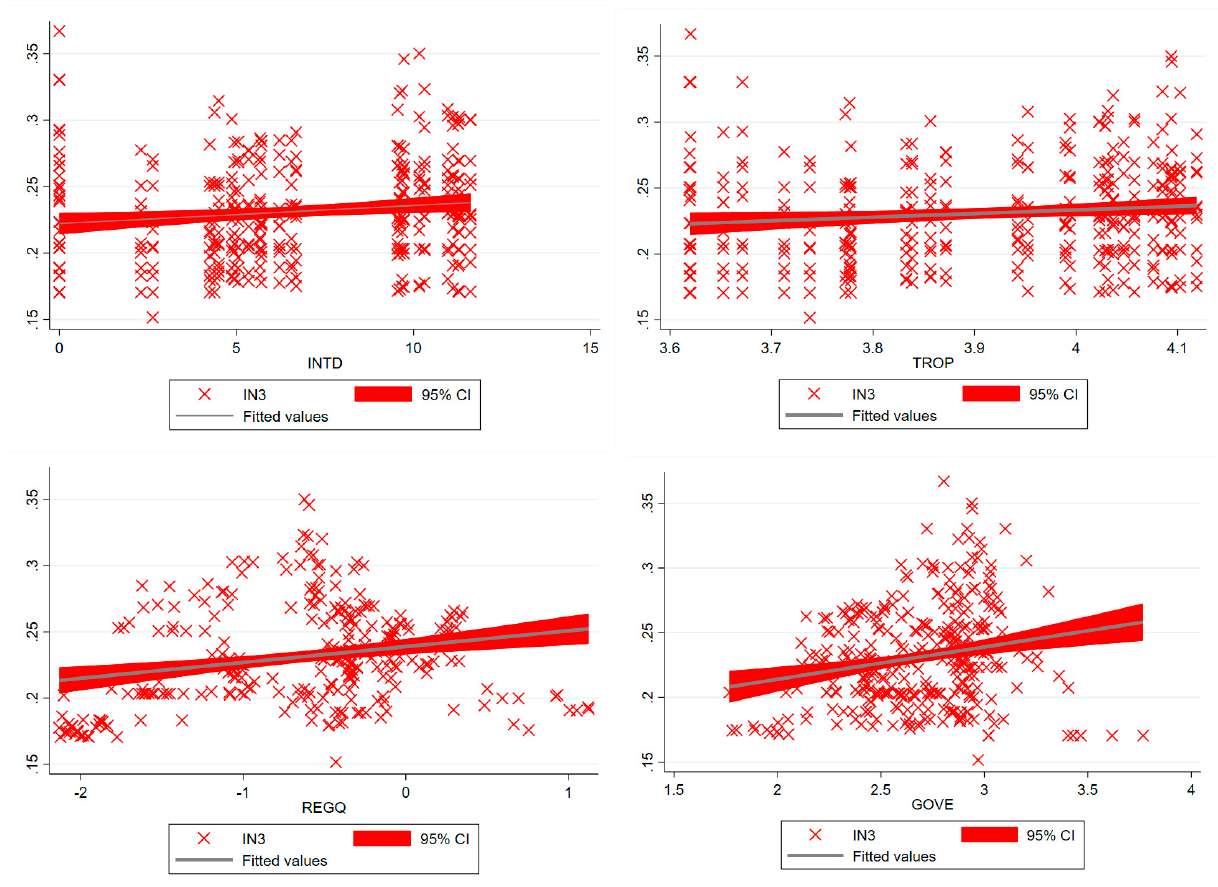
Figure 8. Fitted values for income inequality and globalization dynamics. Note: CI—Confidence